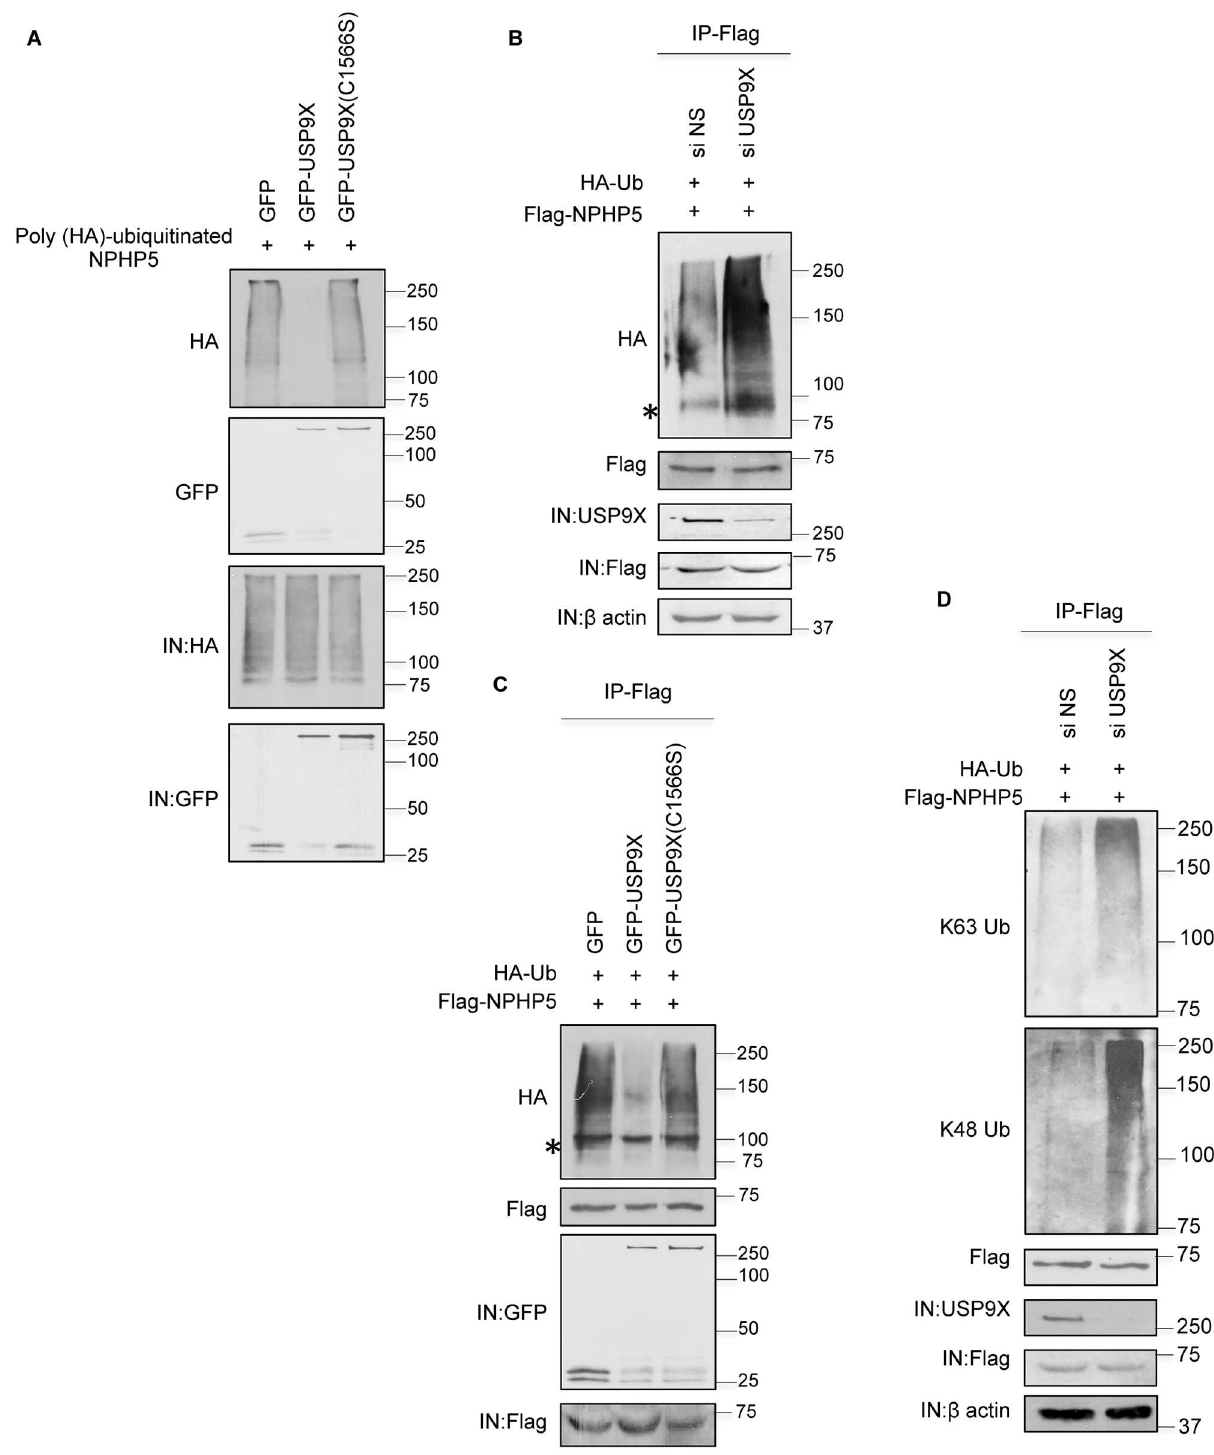
Fig 3. NPHP5 is deubiquitinated by USP9X. A) In vitro deubiquitinationassays were performed by addingpoly (HA)-ubiquitinated NPHP5 as a substrate to GFP, GFP-USP9X wild type or mutant (C1566S) bound to beads. Poly (HA)-ubiquitinated NPHP5 and GFP proteins in the reactionmixture were detected by immunoblotting with anti-HA and anti-GFP antibodies,respectively.IN, input. B, D) HEK293 cells were transfected with control (NS) or USP9X siRNA and plasmidsexpressingFlag-NPHP5 and HA-Ub. Lysates were subjectedto immunoprecipitation with anti-Flag antibody in 1% SDS and Western blotted with the indicatedantibodies. IN, input. C) HEK293 cells were transfected with GFP, GFP-USP9X wild type or mutant (C1566S), Flag-NPHP5 and HA-Ub. Lysates were immunoprecipitated with anti-Flag antibody in 1% SDS and Western blotted with the indicatedantibodies.IN, input. Asterisks indicate non-specific bands.